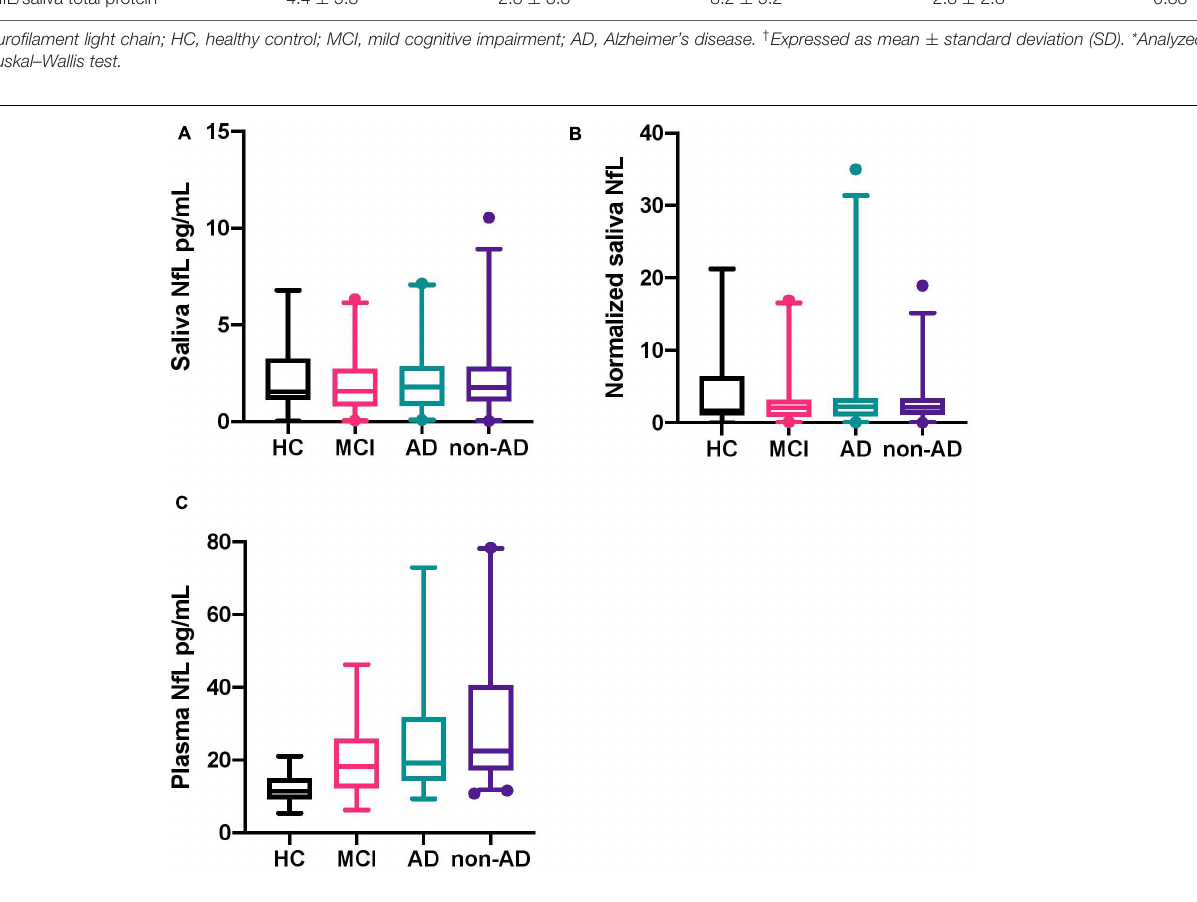
Frontiers in Aging Neuroscience |